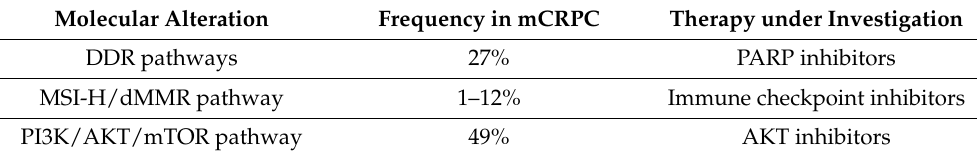
Table 1. Novel targeted therapies. Molecular Alteration Frequency in